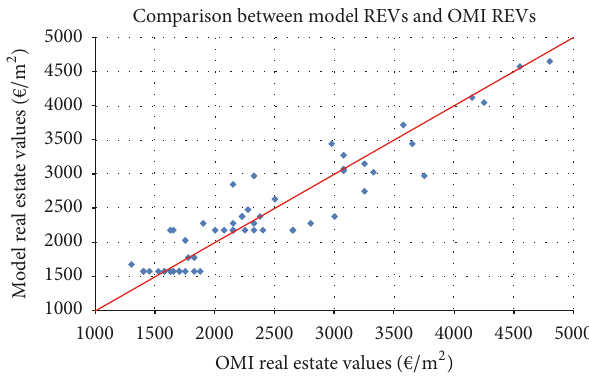
Figure 10: Model versus real estate